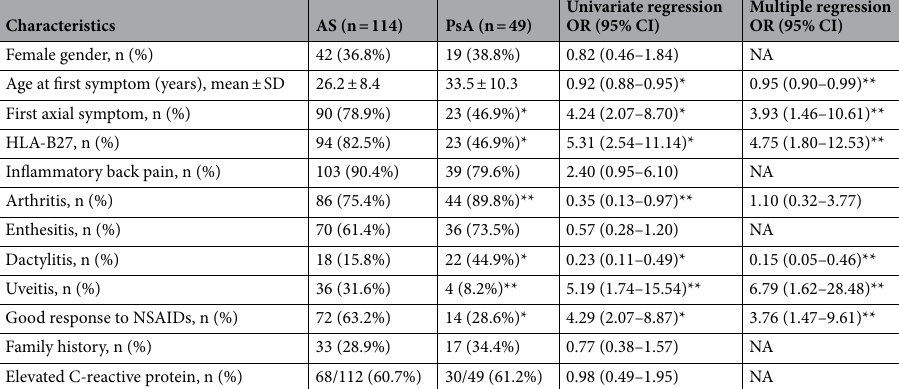
Table 4. Characteristics of ankylosing spondylitis and axial psoriatic arthritis subgroups, and factors associated with ankylosing spondylitis. Logistic regression analysis was used to identify factors significantly different between patients with ankylosing spondylitis and patients with psoriatic arthritis with axial involvement; the dependent factor was ankylosing spondylitis. AS ankylosing spondylitis, 95% CI 95% confidence interval, Family history presence in first-degree or second-degree relatives of any of the following: ankylosing spondylitis, psoriasis, uveitis, reactive arthritis, or inflammatory bowel disease, First axial symptom first presentation with inflammatory back pain and/or buttock pain, NA not applicable, NSAIDs non-steroidal anti-inflammatory drugs, OR odds ratio, PsA psoriatic arthritis with axial involvement. * p -value < 0.001; ** p- value <